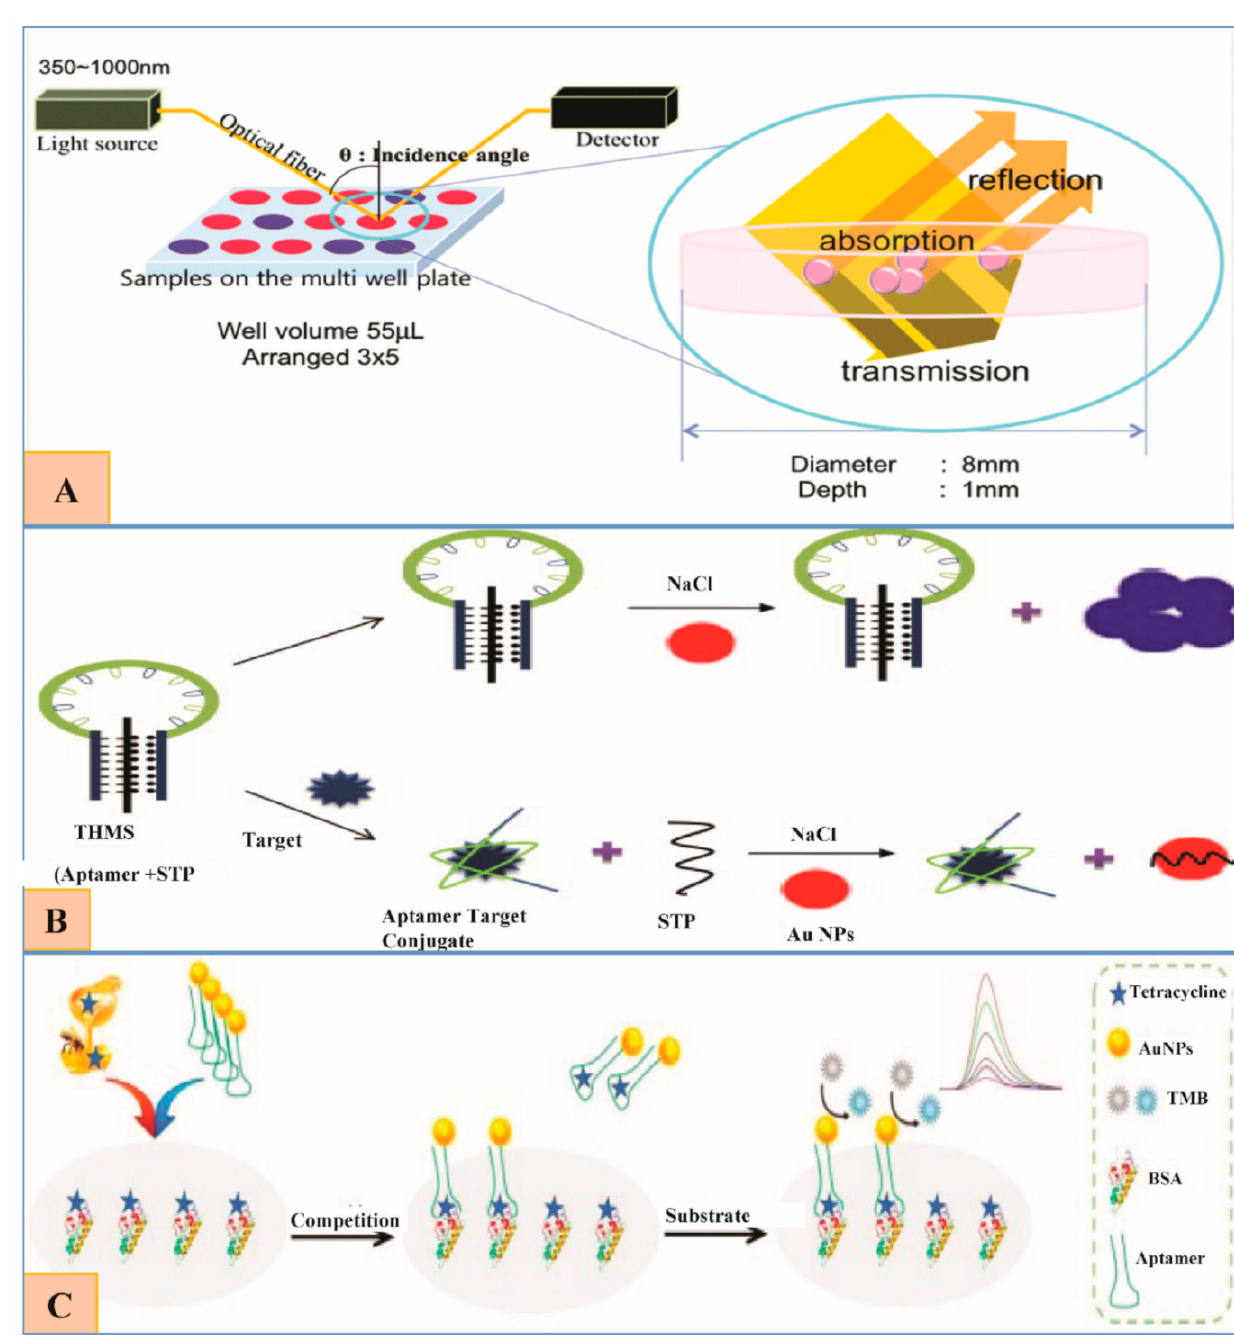
Figure 6. ( A ) The schematics showing the reflectance-based multi-well plate colorimetric aptasensor using AuNPs (Repro- duced with permission from [50] © 2015 Royal Society of Chemistry). ( B ) Schematic explanation of TET detection based on colorimetric triple-helix molecular switch (THMS). In the absence of Tetracycline (TET), THMS (Aptamer + STP) remains stable, resulting in AuNPs aggregation by salt, color changes from red to blue. In the presence of TET, aptamer binds to its target, the signal transduction probe (STP) leaves the THMS and adsorbs on the surface of AuNPs thus stabilizing them, so no color change (Reproduced with permission from [87] © 2015 Elsevier). ( C ). Illustration of the proposed gold nanoparticle-linked competition-based aptamer assay (Reproduced with permission from [89] © 2020